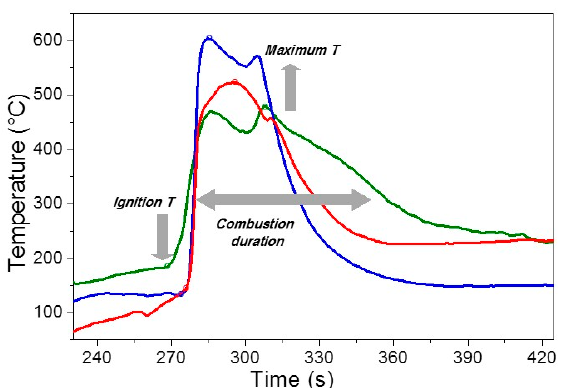
Figure 1. Temperature-time profiles registered during the combustion process of the three investigated samples, SCFC-S (green), SCFC-SP1 (red), and SCFC-SP20 (blue).